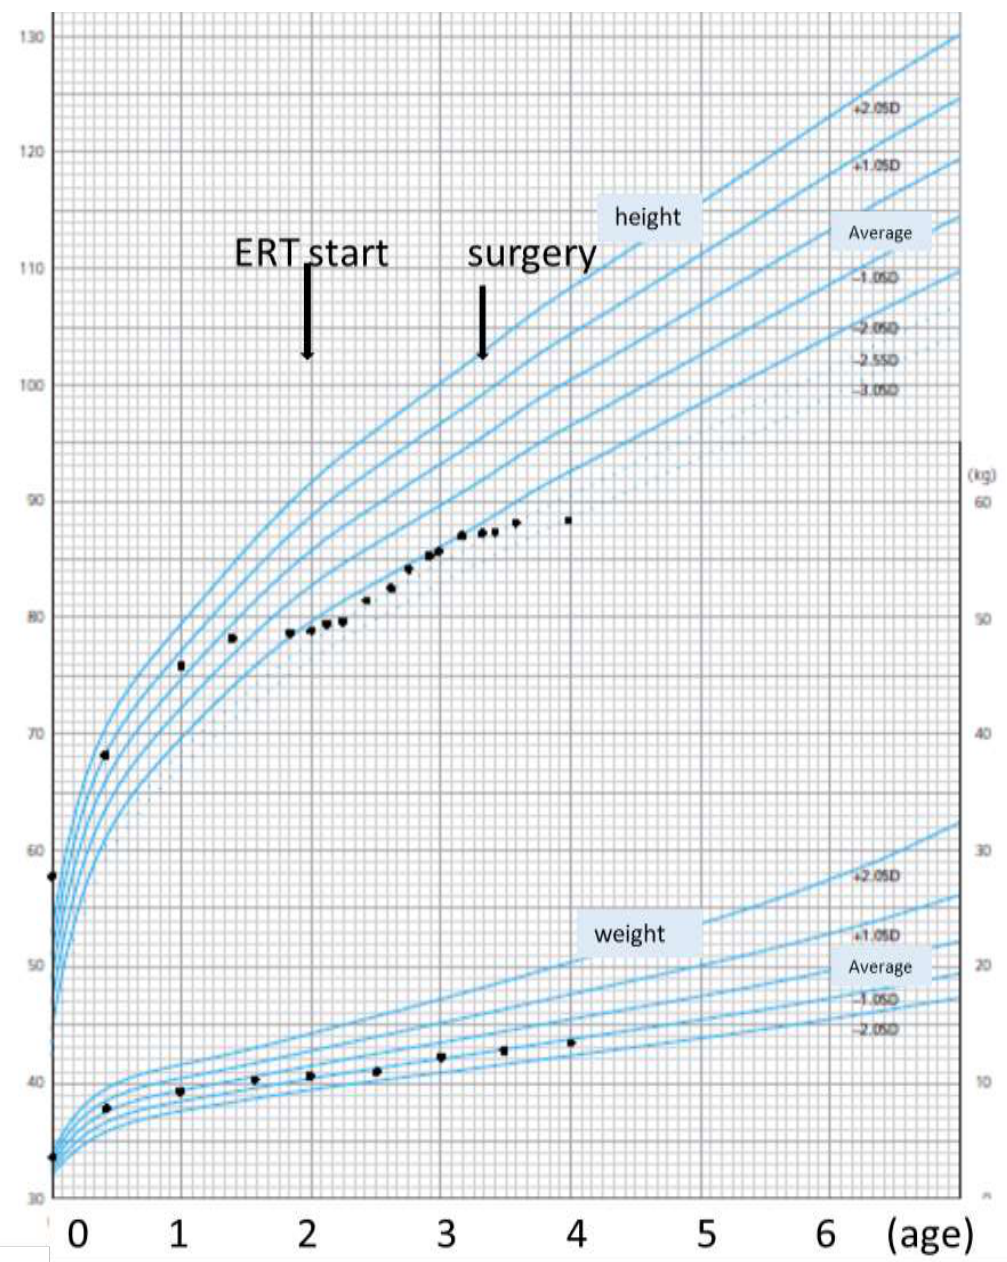
Figure 4. The growth curve of a Japanese boy with MPS IVA. The declining growth velocity of height improved after the initiation of the ERT at the age of 24 months. This chart was referenced from [18].